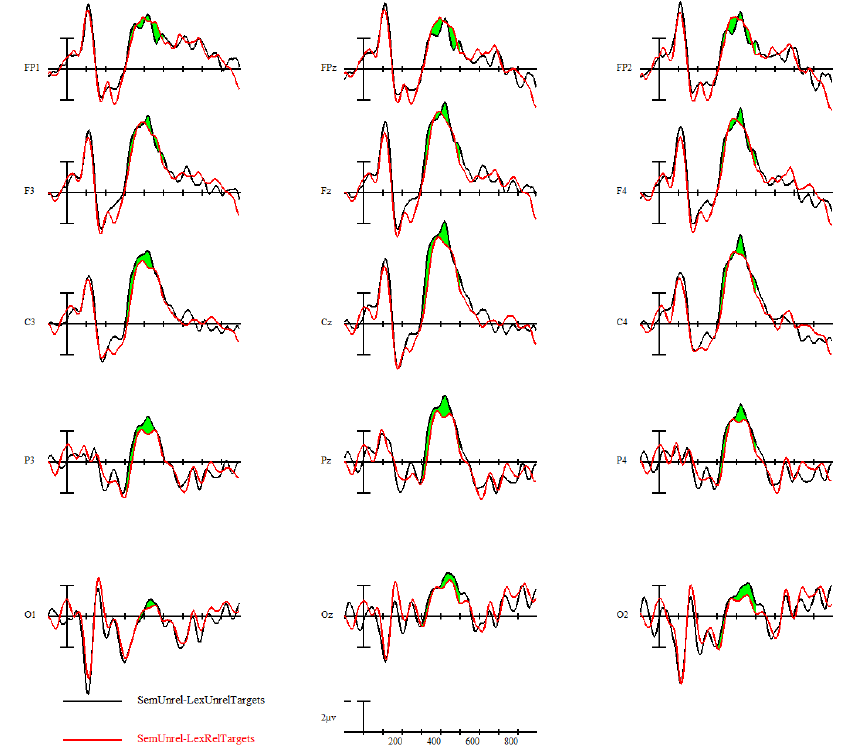
Figure 11. L1 translation lexical priming effect in low-attrition bilinguals ( N = 12).